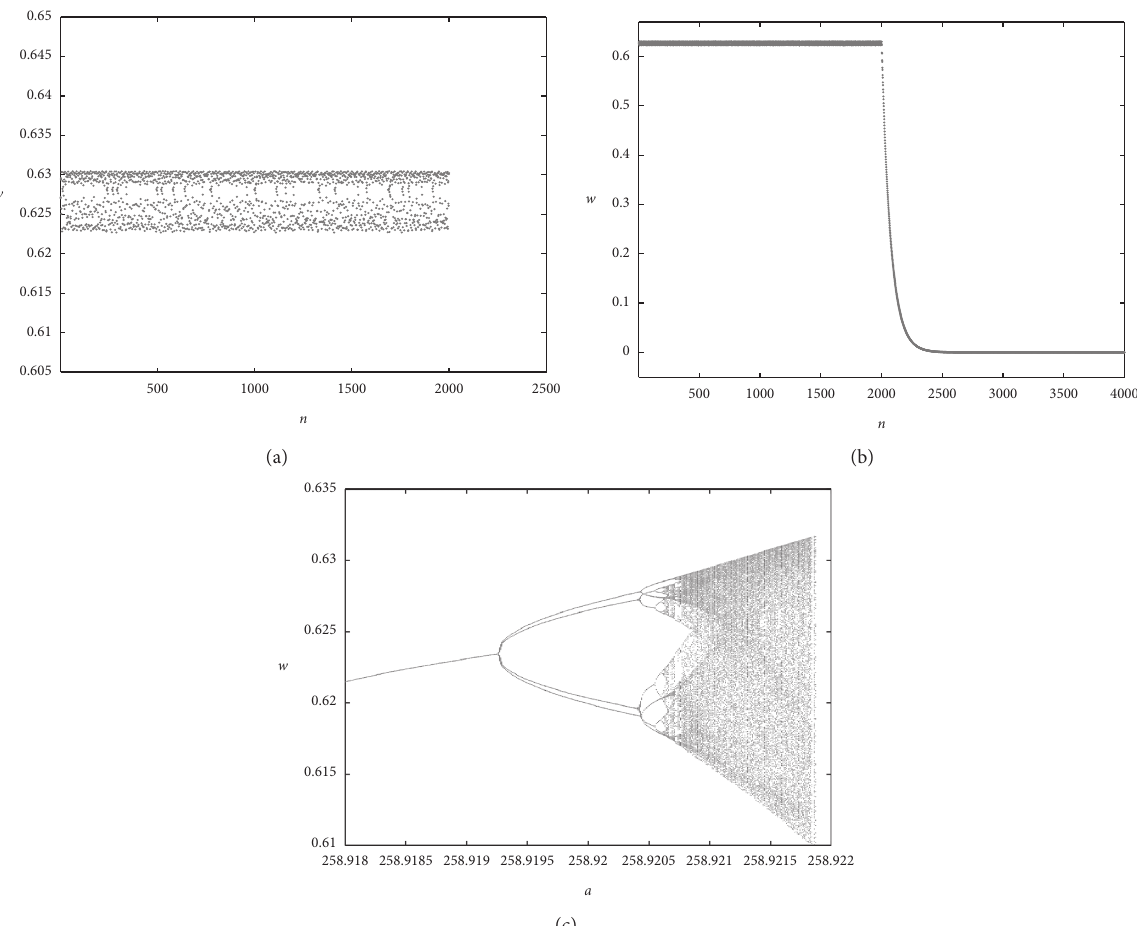
Figure 9: (a) Chaotic behavior of w for uncontrolled system (2). (b) Time responses for the state w of controlled system (61). (c) Bifurcation diagram of controlled system